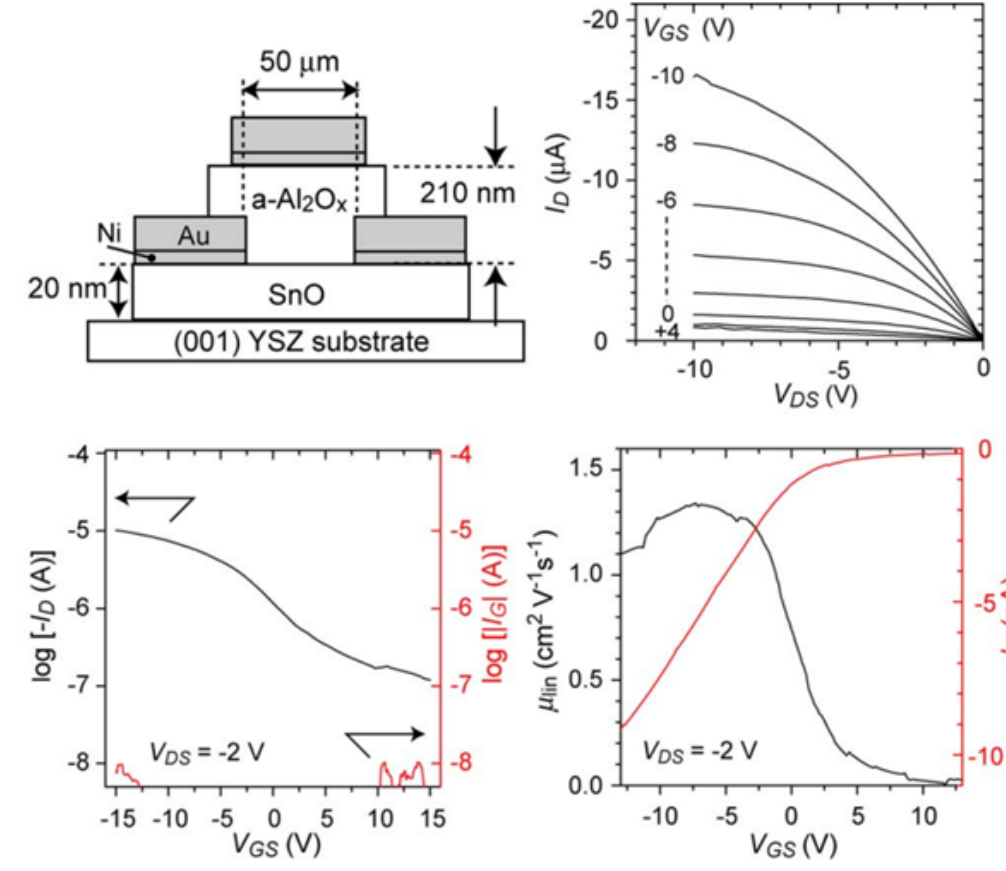
Figure 9: Structure and characteristics of the first p-type SnO TFT [43]